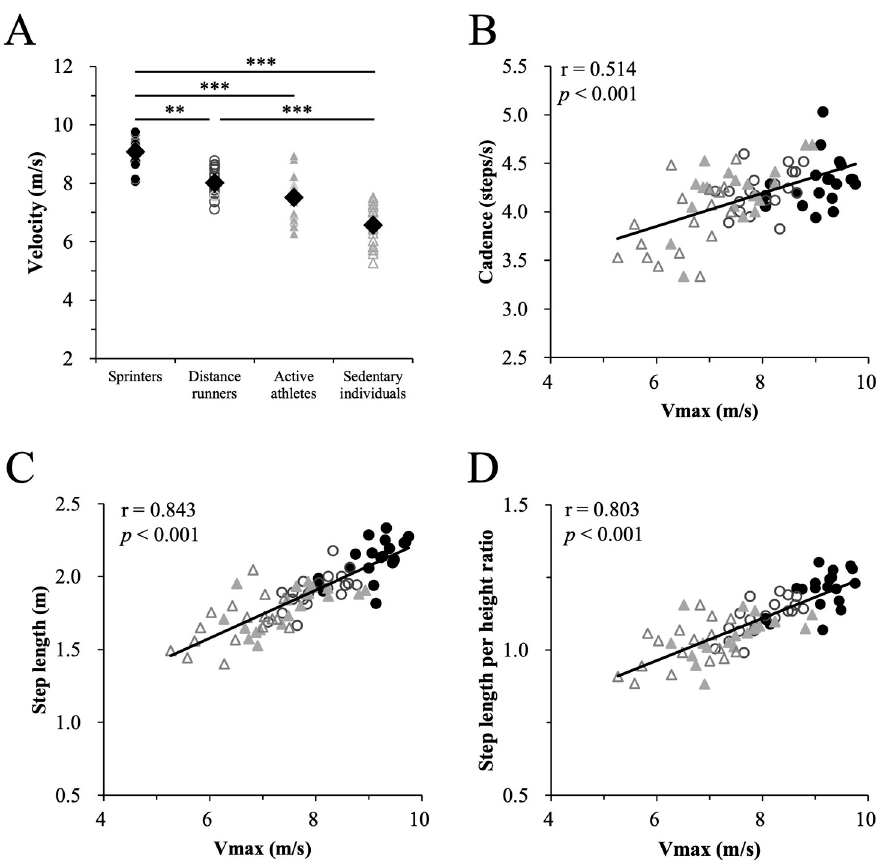
Fig 2. Inter-group comparison of mean values (diamond) of the maximum running velocity (Vmax) (A), and correlation between the maximal running velocity and the cadence (B), step length (C), and step length normalized by height (D) at maximal running velocity. In Fig 2A, open circles indicate each individual subject. Significant difference; ��� p < 0.001, �� p < 0.01. In Fig 2B–2D, filled circles, open circles, filled triangles, and open triangles represent the sprinters, distance runners, active athletes, and sedentary individuals, respectively. There are significant positive correlations between Vmax and the cadence (B) and between Vmax and step length, both absolute velocity and velocity normalized to maximal running velocity (r = 0.514, p < 0.001; r = 0.843, p < 0.001; r = 0.803, p < 0.001,